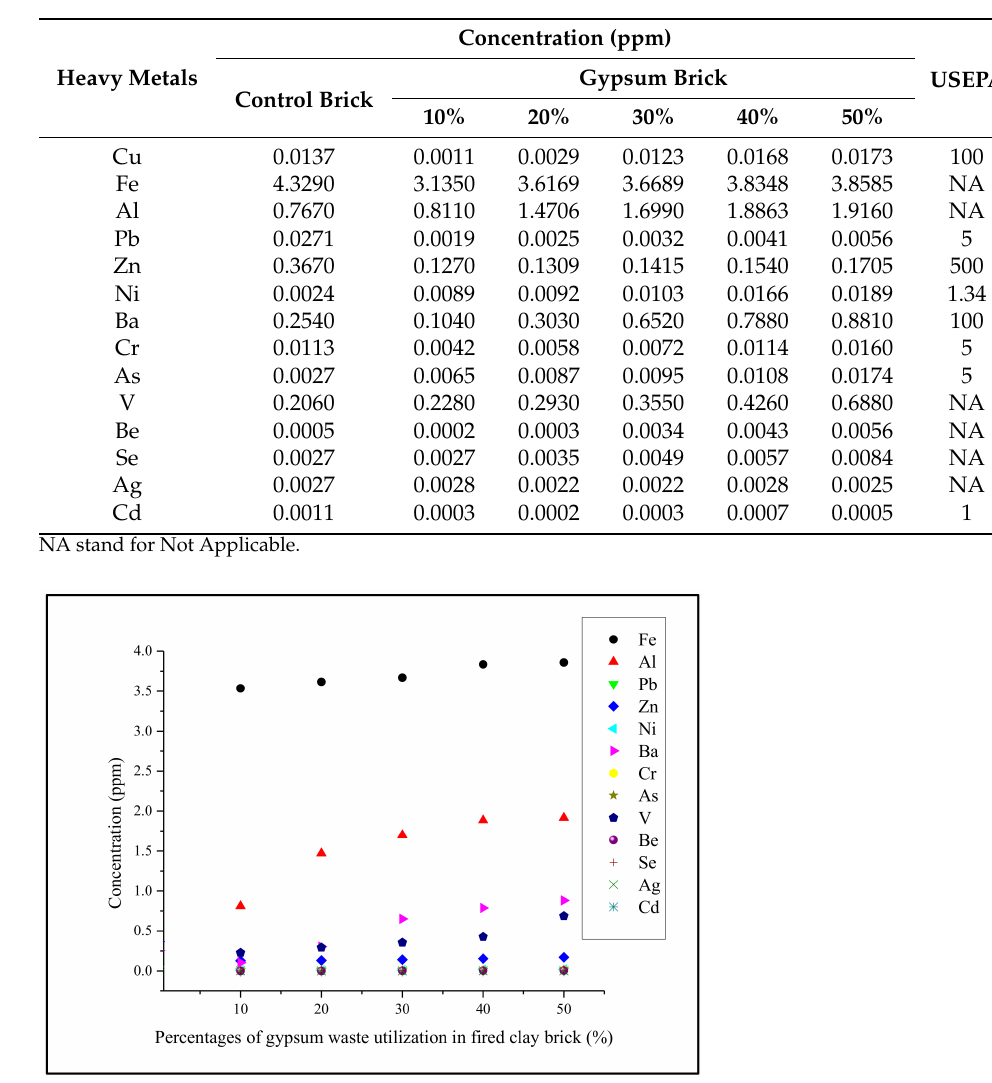
Table 4. Heavy metals in fired clay brick samples by using SPLP.